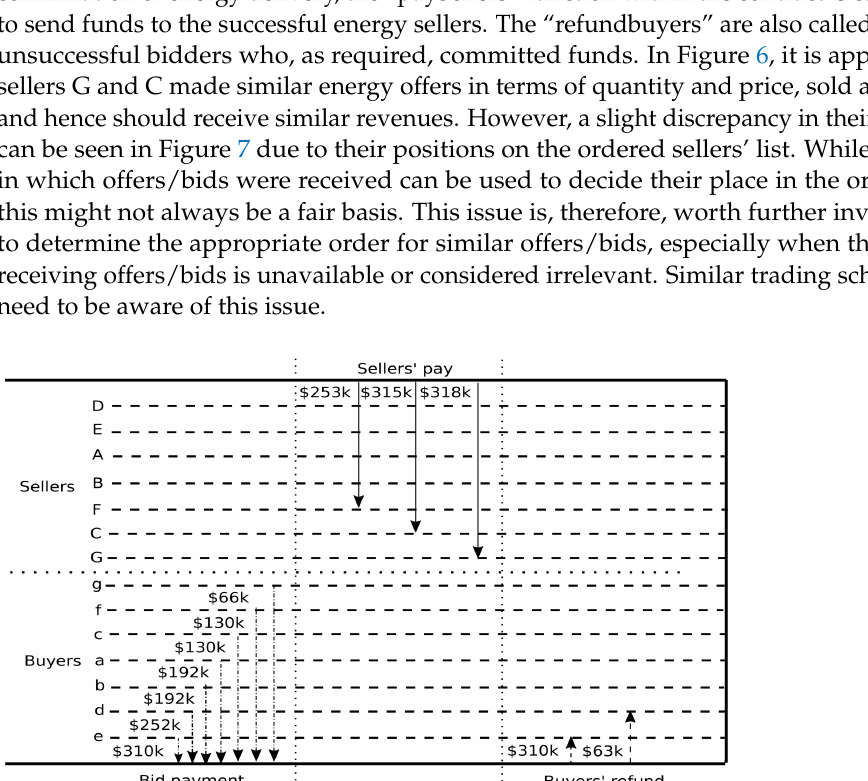
Figure 7. Smart contract execution of energy double auction payments. Energy buyers make payment along with their bids, to the smart contract. The contract pays successful sellers and refunds unsuccessful bidders.